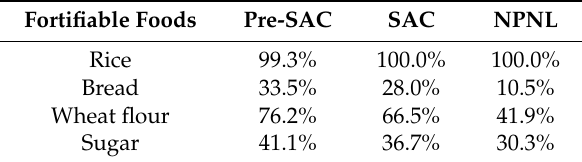
Table 3. Percentage of people consuming rice, bread, wheat flour, and sugar by population group.